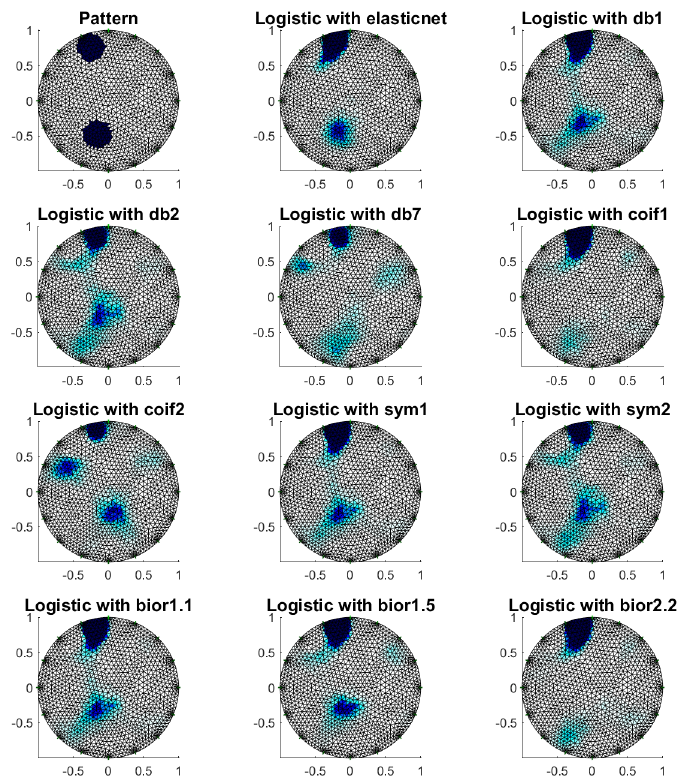
Figure 10. Image reconstruction for two objects—example 3.